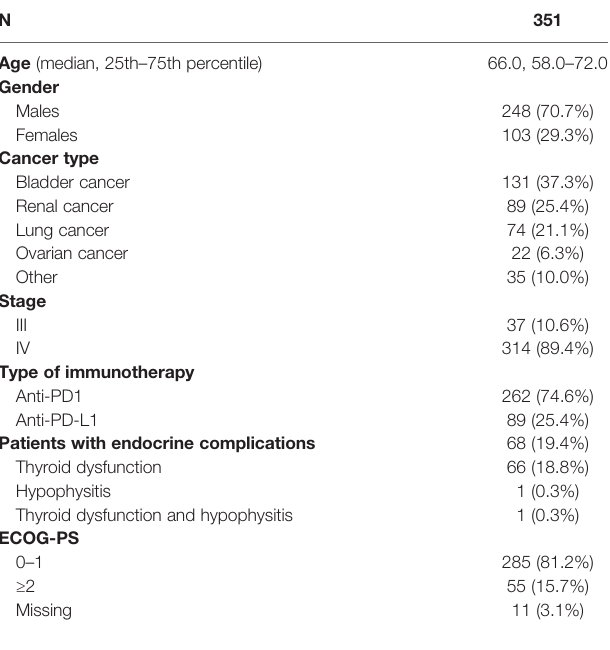
TABLE 1 | Patients ’